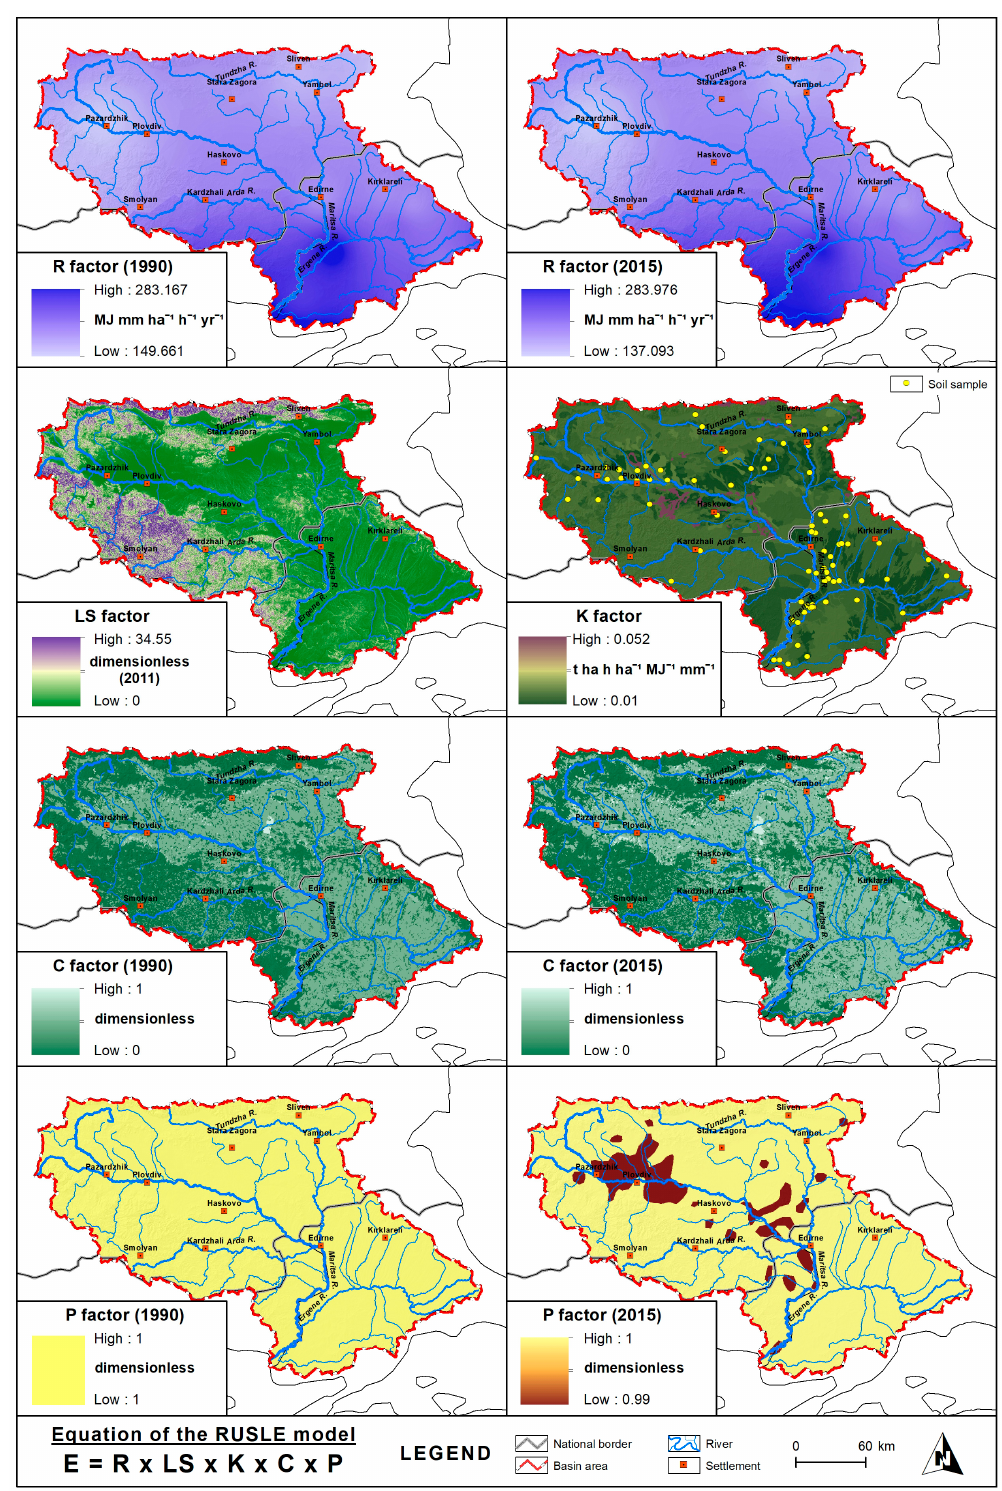
Figure 3. Spatiotemporal distribution of input parameters in RUSLE.